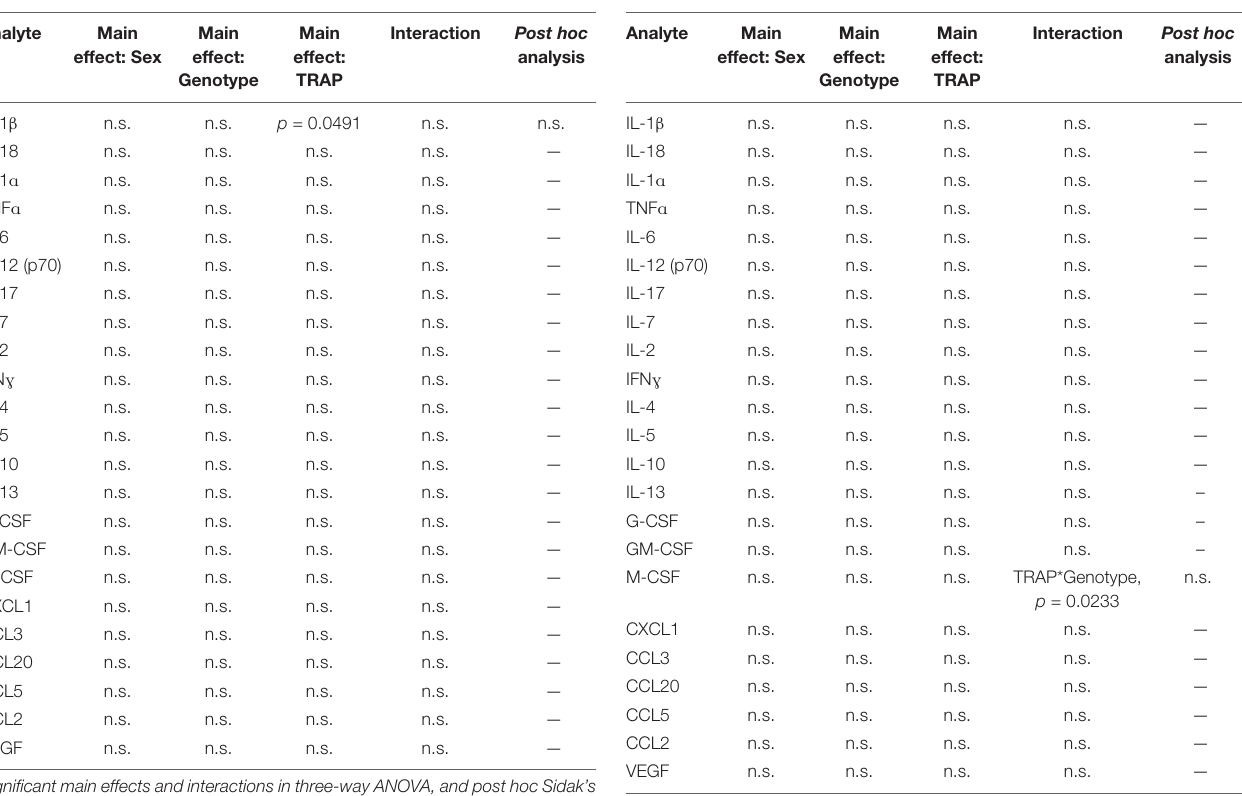
TABLE 4 | Summary of statistical comparisons for levels of cytokines, chemokines, and growth factors in the hippocampus of 15-month-old TgF344-AD and WT rats exposed to TRAP or FA for 14